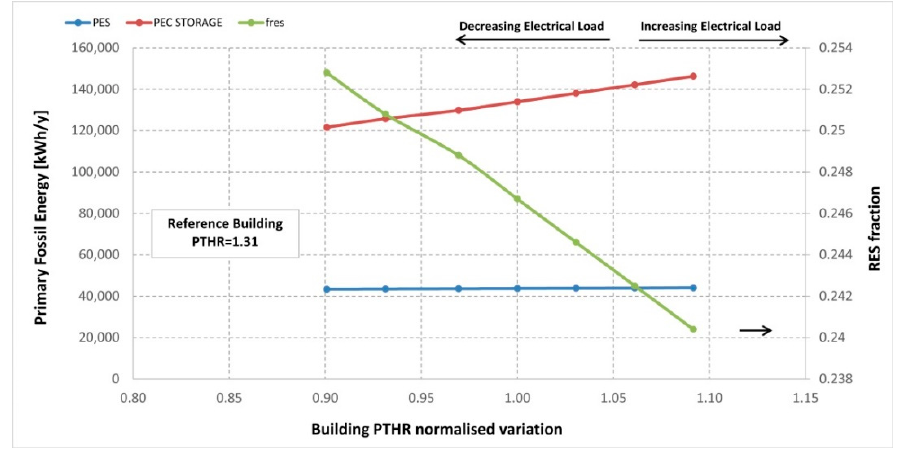
Figure 14 Sensitivity analysis on Performance indicators with changes in Thermal loads when a batteries bank is connected.